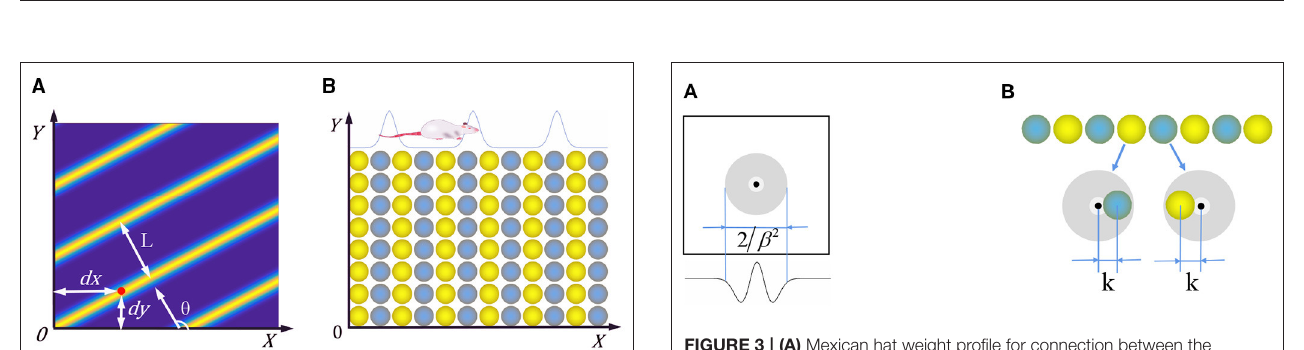
FIGURE 3 | (A) Mexican hat weight profile for connection between the neurons. (B) Weight offset contour of stripe cells. same as the priority direction of the upstream head direction cells. Furthermore, the priority direction of the left and right adjacent neurons i and j is opposite. The inhibitory weight matrix of the neuron to the surrounding neurons will shift toward its priority direction. According to the principle of “Turing pattern dynamics,” when there is only inhibitory input between neurons, the interaction between neurons causes the neural plate to form steady striped firing spontaneously. Half of the neurons are excited when there is a certain direction of the velocity input, and another half do not respond. So the original static striped firing balance is broken. The firing pattern of the stripe cells spontaneously shifts along the velocity direction. As shown in Figure 3B , the central position of the weight matrix of stripe cells is x − k and x + k . We set γ = 1.035 × β and β = 3 /λ 2 , λ is the firing period on the neural plate. Since the W 0 is always less than or equal to zero, all the connections are inhibitory, and locally surrounding inhibitory connections interact to generate a striped